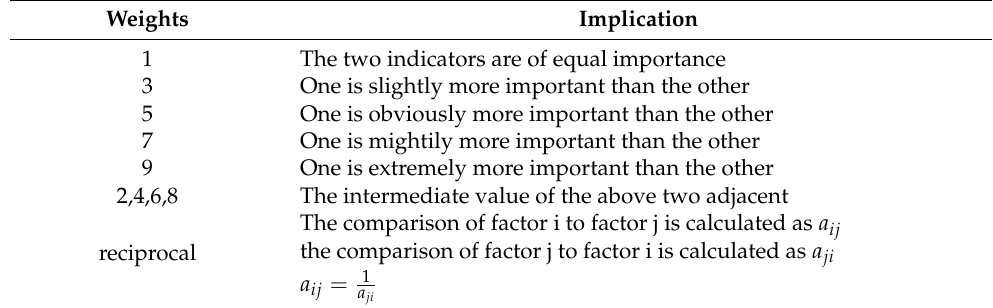
Table 2. Weights of judgment